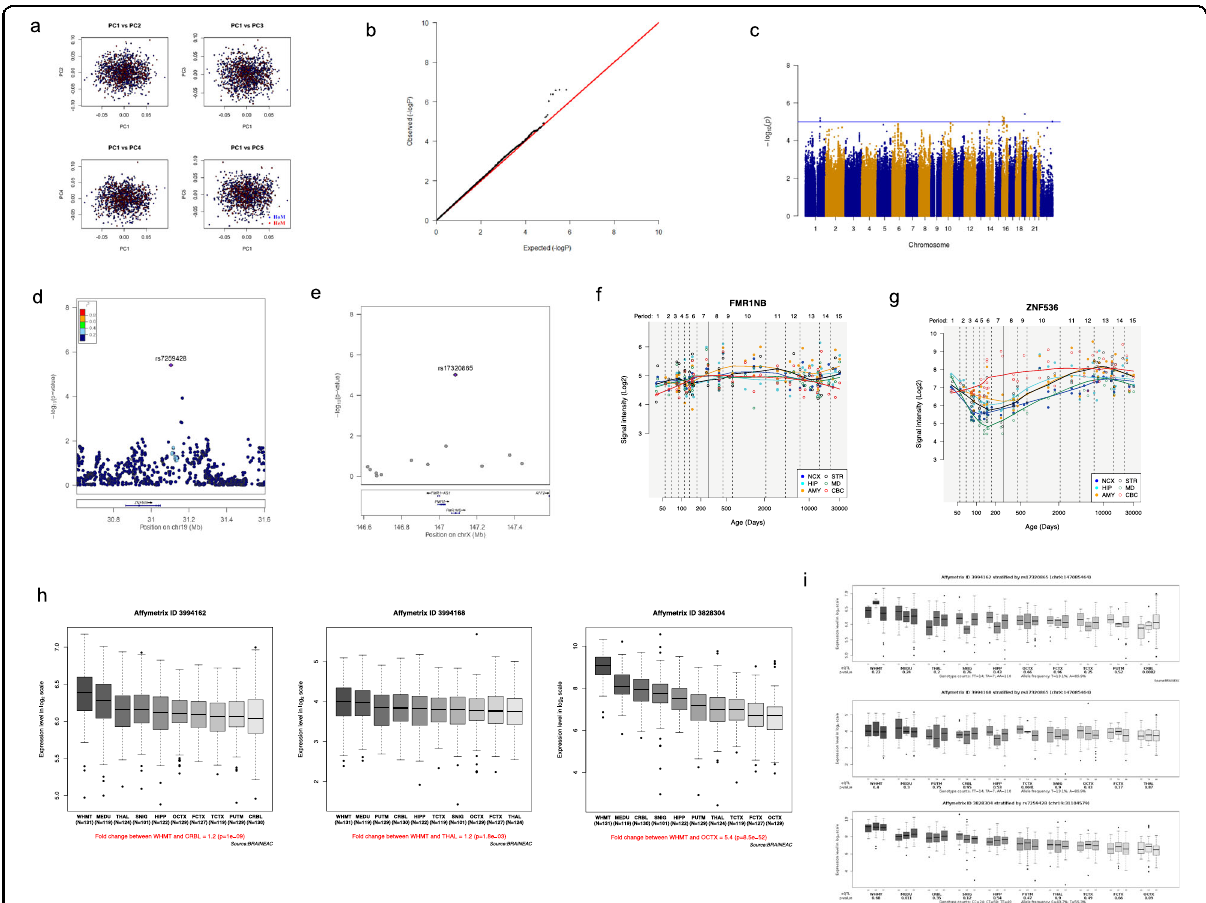
Fig. 1 Genome-wide association analysis of the Han Chinese population. a Principal component analysis of homosexual men versus heterosexual men. b Quantile-quantile plots of the association results of 521 homosexual men and 1270 heterosexual controls (in fl ation factor λ GC = 1.02) from the discovery phase. Results. Overall association results from the discovery phase. c – e Manhattan plots of P values derived from Cochran- Armitage trend tests in the discovery phase, with 521 homosexual men and 1270 heterosexual controls ( c ); regional plots of the two loci (rs17320865 and rs7259428) associated with male sexual orientation ( d , e ). f The expression pro fi le of FMR1NB using the HBT database. g The expression pro fi le of ZNF536 using the HBT database. h Differences in the expression levels of FMR1NB and ZNF536 transcripts across various 10 brain regions by using the BRAINEAC database (ID 3994162; ID 3994168; ID 3828304). i Difference of expression level of FMR1NB and ZNF536 transcripts across 10 various brain regions by using the BRAINEAC database (ID 3994162; ID 3994168; ID